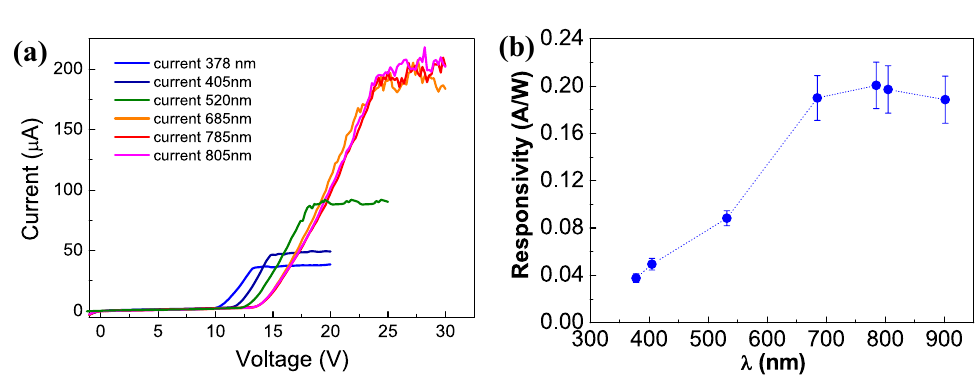
Figure 8. ( a ) I–V characteristics as a function of reverse bias voltage at laser light wavelengths from 378 to 805 nm; ( b ) rGO/n-Si responsivity versus light